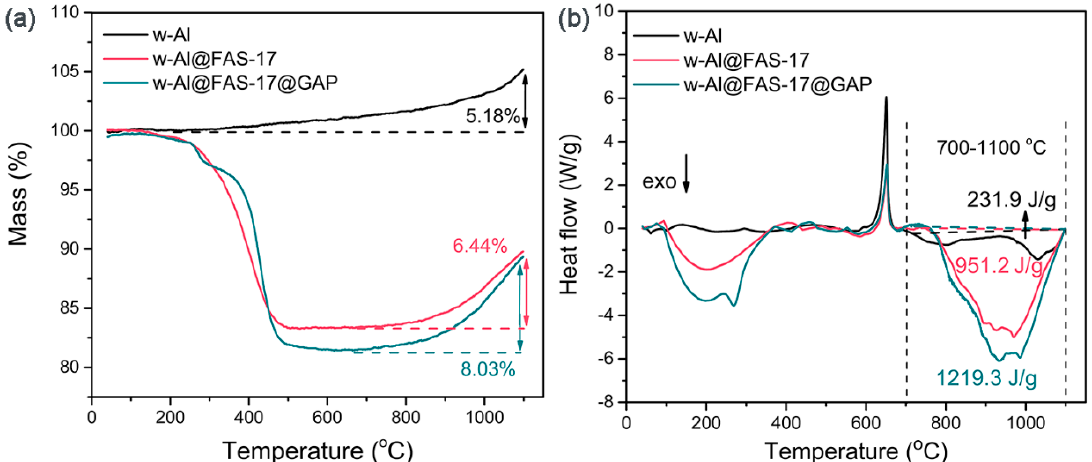
Figure 4. TGA curves with comparison of weight gains ( a ), DSC curves with exothermic enthalpy energy at 700–1100 ◦ C ( b ) of w-Al, w-Al@FAS-17 and